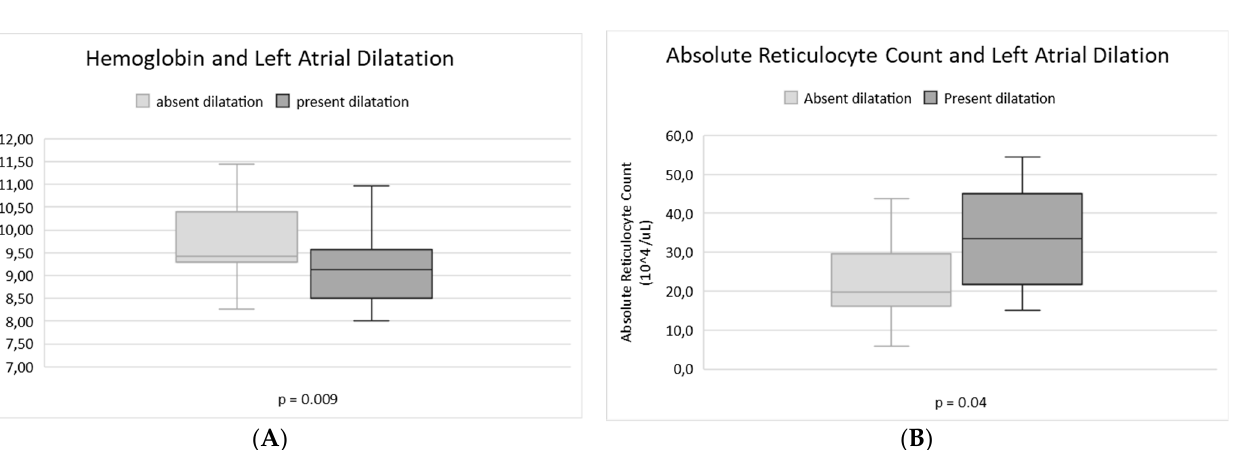
Table 2. Echocardiographic values of the cohort ( n = 64).